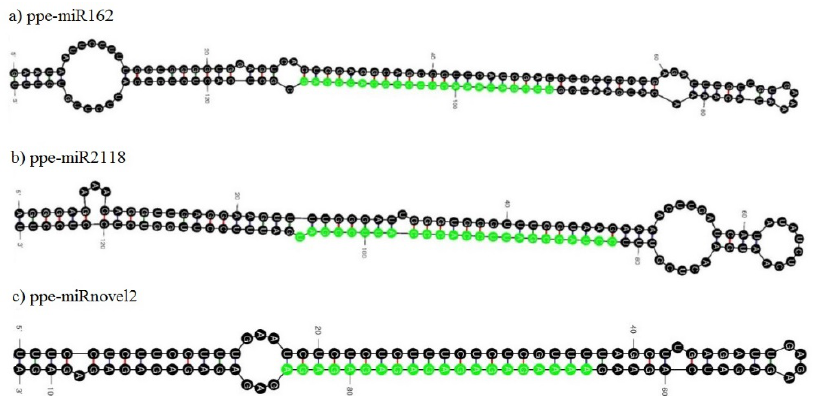
Figure 2: Secondary structure representations of selected known and novel